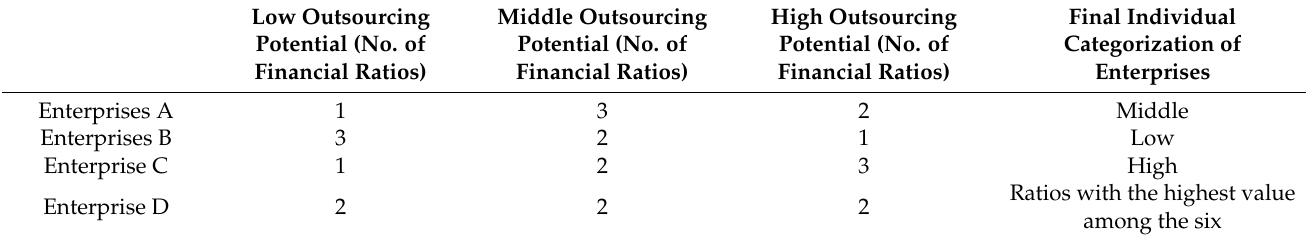
Table 5. Example on deciding the final outsourcing potential for enterprises based on financial ratio